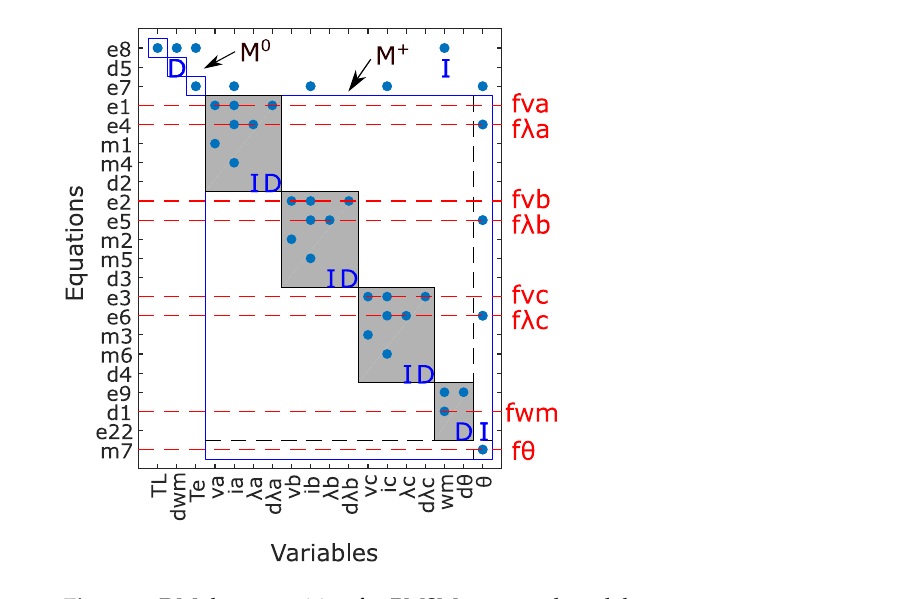
Figure 5. DM decomposition for PMSM structural